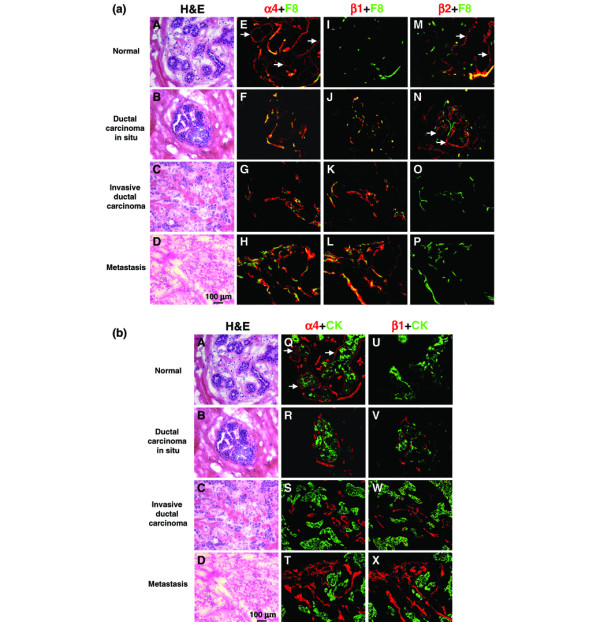
Immunohistochemistry of human breast tissues including normal, DCIS, primary IDC and metastases. (a) Panels A–D: hematoxylin and eosin staining of normal breast, DCIS, IDC and metastatic tissues, respectively. Panels E–H: double immunostaining with laminin α4 (red) and an endothelial marker, von Willebrand factor/factor-8 (F8; green). Panels I–L: double immunostaining with laminin β1 (red) and an endothelial marker von Willebrand factor (F8, green). Panels M–P: double immunostaining for laminin β2 (red) and F8 (green). For each representative case, serial sections are shown. (b) Panels A–D: hematoxylin and eosin staining (same as in Fig. 1a, panels A–D). Panels Q–T: double immunostaining for laminin α4 chain (red) and lining epithelium markers cytokeratins (CK)-8/18 (green). Panels U–X: double immunostaining for laminin β1 (red) and CK-8/18 (green). For each case, serial sections to Fig. 1a are shown. Because of lack of appropriate antibodies, no double staining could be performed for laminin β2 chain and CK-8/18. In normal breast tissues, laminin-9 chains α4 and β2 are expressed in BMs of mammary gland ducts (arrows in Fig. 1a, panels E and M, and Fig. 1b, panel Q) and blood vessels. In DCIS laminin α4 chain starts disappearing from ductal BMs (Fig. 1a, panel F, and Fig. 1b, panel R) but β2 chain is present (Fig. 1a, panel N [arrows]). Laminin-8 chains α4 and β1 and laminin-9 chains α4 and β2 colocalize in some microvessels. In all invasive ductal carcinomas, laminin-8 α4 and β1 chains are both found in BMs of F8-positive microvessels (Fig. 1a, panels G and K). Laminin-9 is absent (no β2 chain; Fig. 1a, panel O). In metastases of breast carcinoma, laminin-8 chains are seen in microvascular BMs (Fig. 1a, panels H and L; Fig. 1b, panels T and X) but laminin-9 is absent again (no β2 chain; Fig. 1a, panel P). BM, basement membrane; DCIS, ductal carcinoma in situ; IDC, invasive ductal carcinoma.